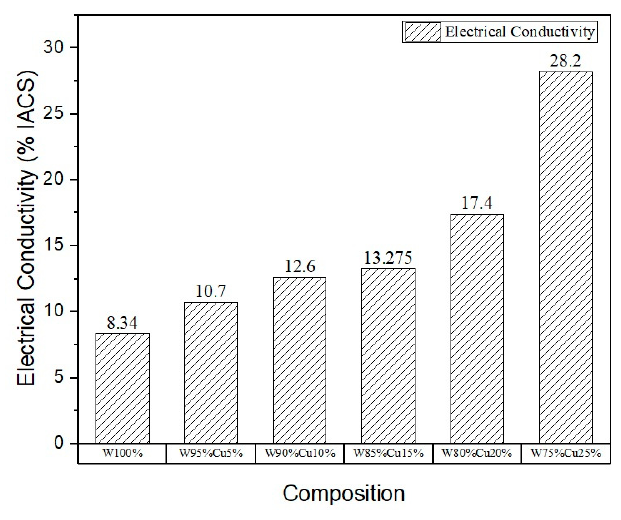
Figure 11. Electrical conductivity of the sintered samples.